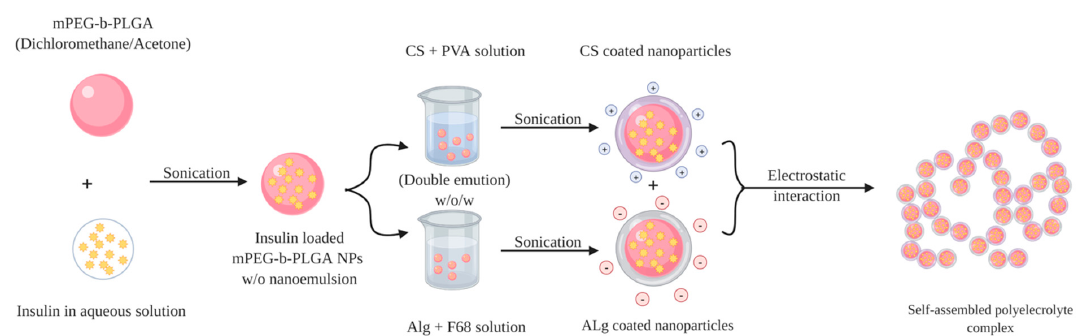
Figure 10. Schematic representation of the double emulsion method used to prepare insulin-loaded polyelectrolyte complexes. Positively charged chitosan nanoparticles (CSNPs) and negatively charged alginate nanoparticles (AlgNPs) are prepared, respectively, then two kinds of nanoparticles are mixed together to self-assemble forming polyelectrolyte complexes by electrostatic interaction.